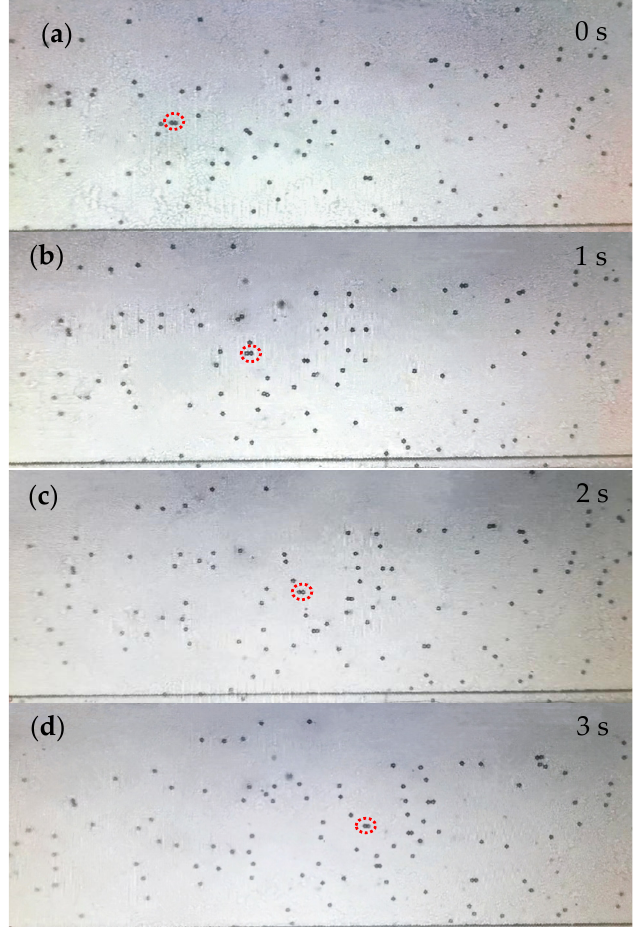
Figure 8. Images showing the pumping behavior at 20.0 kHz by indicating the movement of polystyrene beads in acoustic micropump at di ff erent time frames when ( a ) t = 0 s, ( b ) t = 1 s, ( c ) t = 2 s, ( d ) t = 3 s.